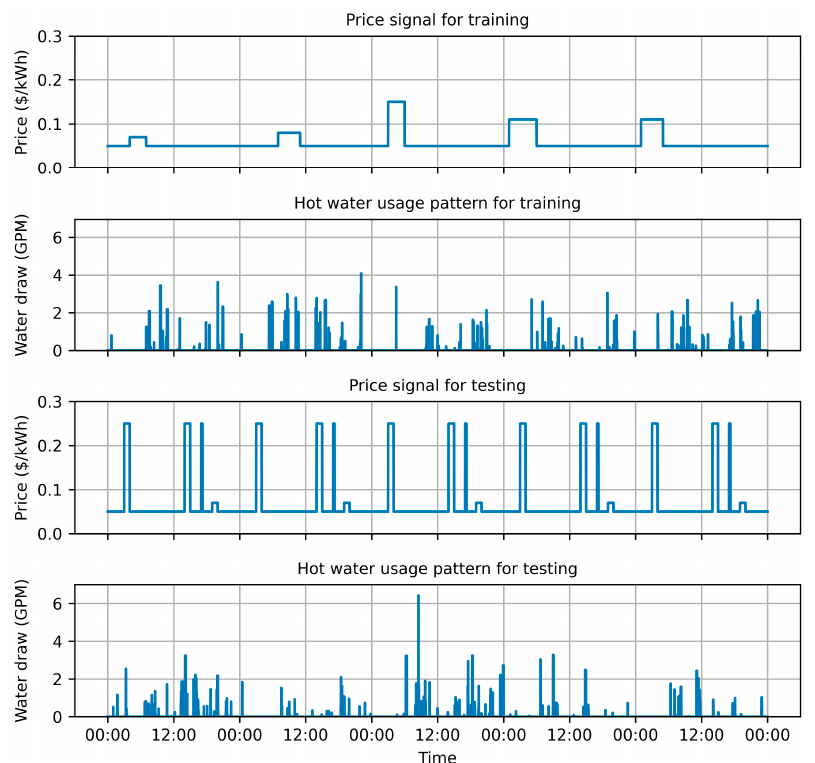
Figure 4. Simulator performance.